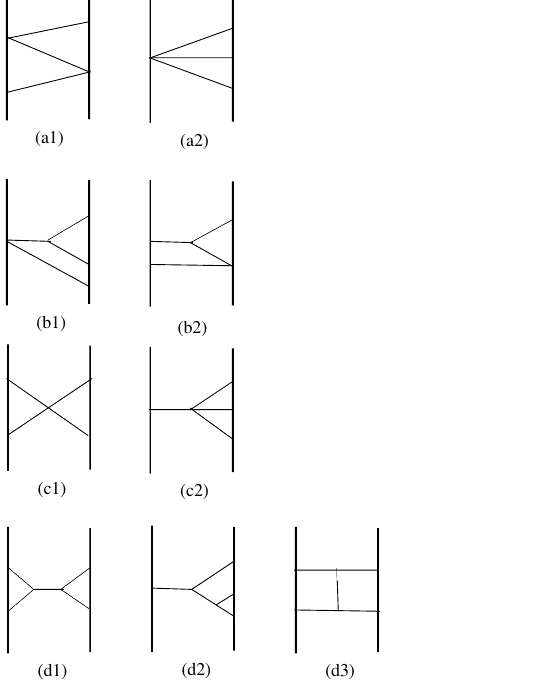
Figure 3 . Graph topologies at order G 3 : (a) No self-interaction vertices. (b) One cubic vertex. (c) One quartic vertex. (d) Two cubic vertices. Topologies (c) and (d) constitute two-loop topologies in the worldline picture. The topology (d3) is a rank-two topology as specified